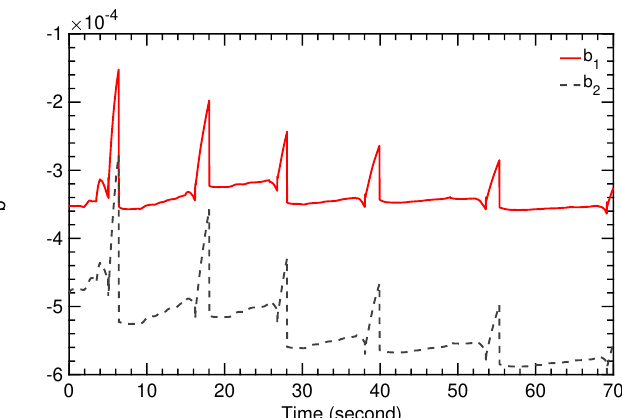
Figure 19. Time history of TF coefficients b 1 and b 2 .